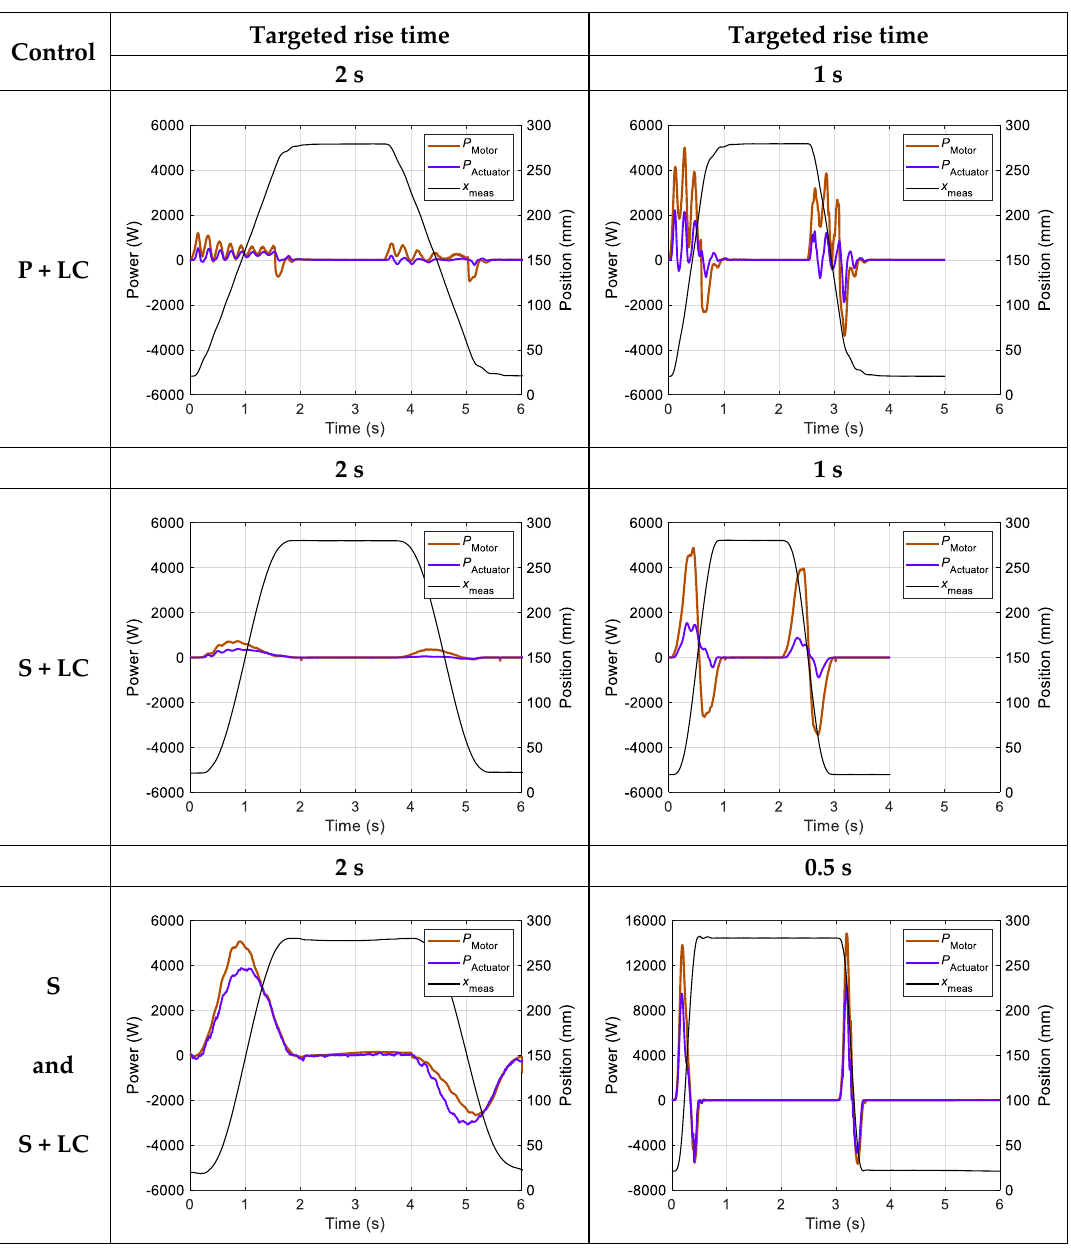
Figure 7. Electric motor’s mechanical output power and the actuator’s hydraulic power together with the actuator position with different controllers, load compensation (LC) arrangements, and rise times.